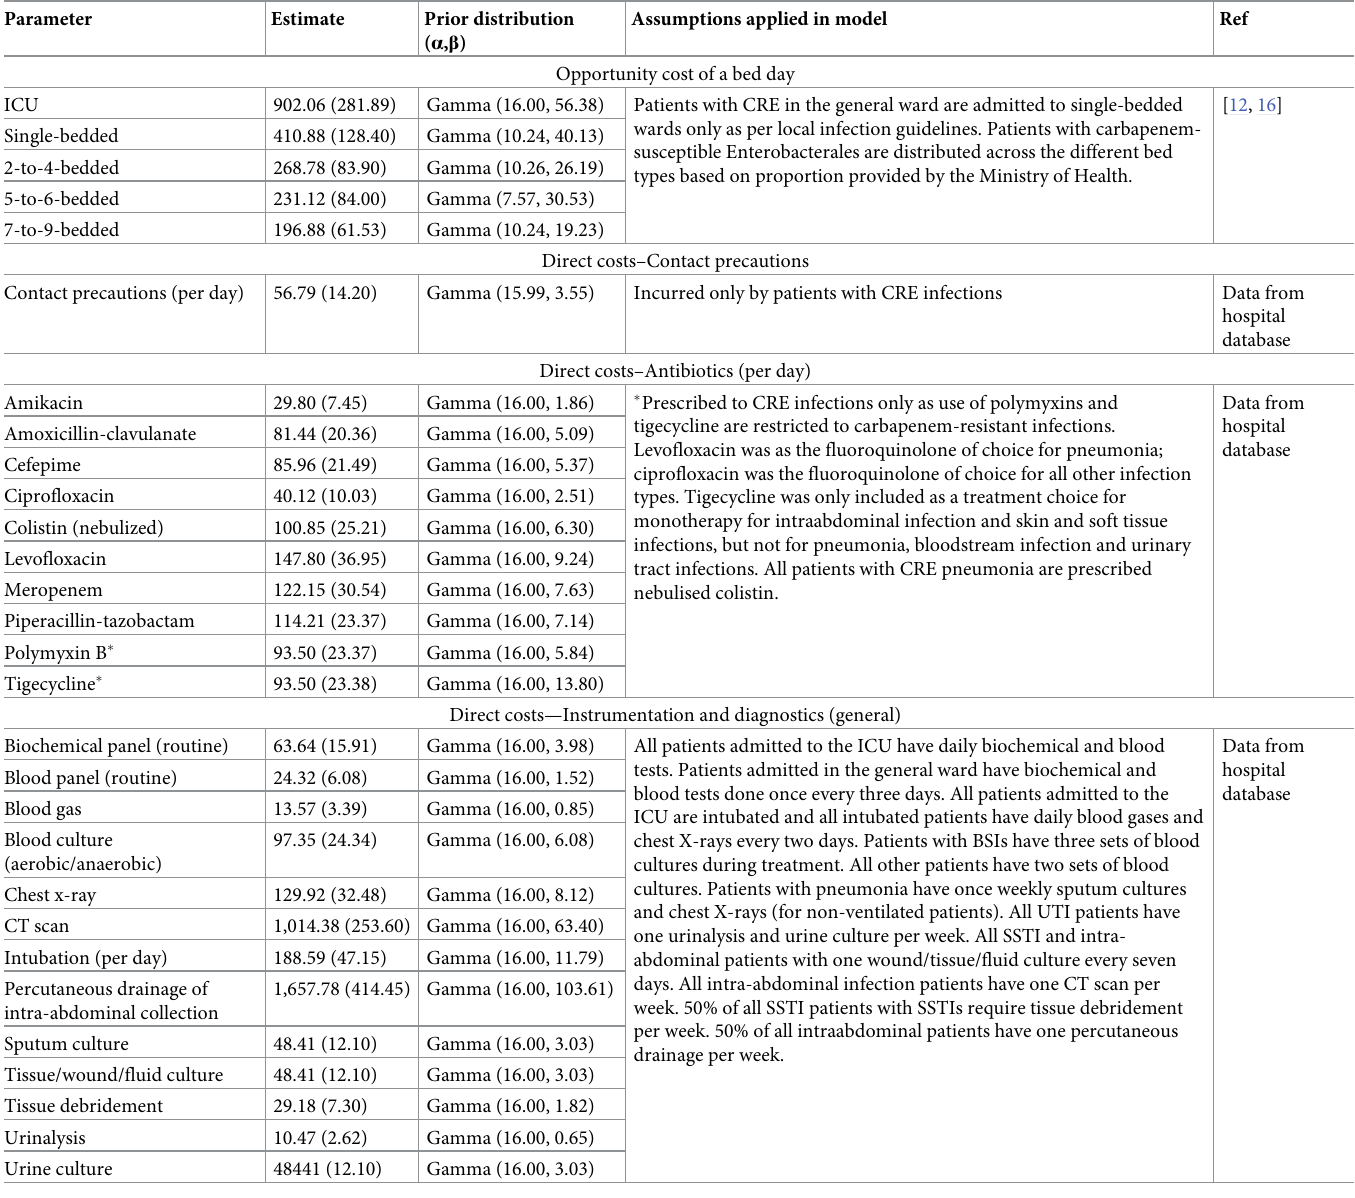
Table 2. Model inputs and assumptions for